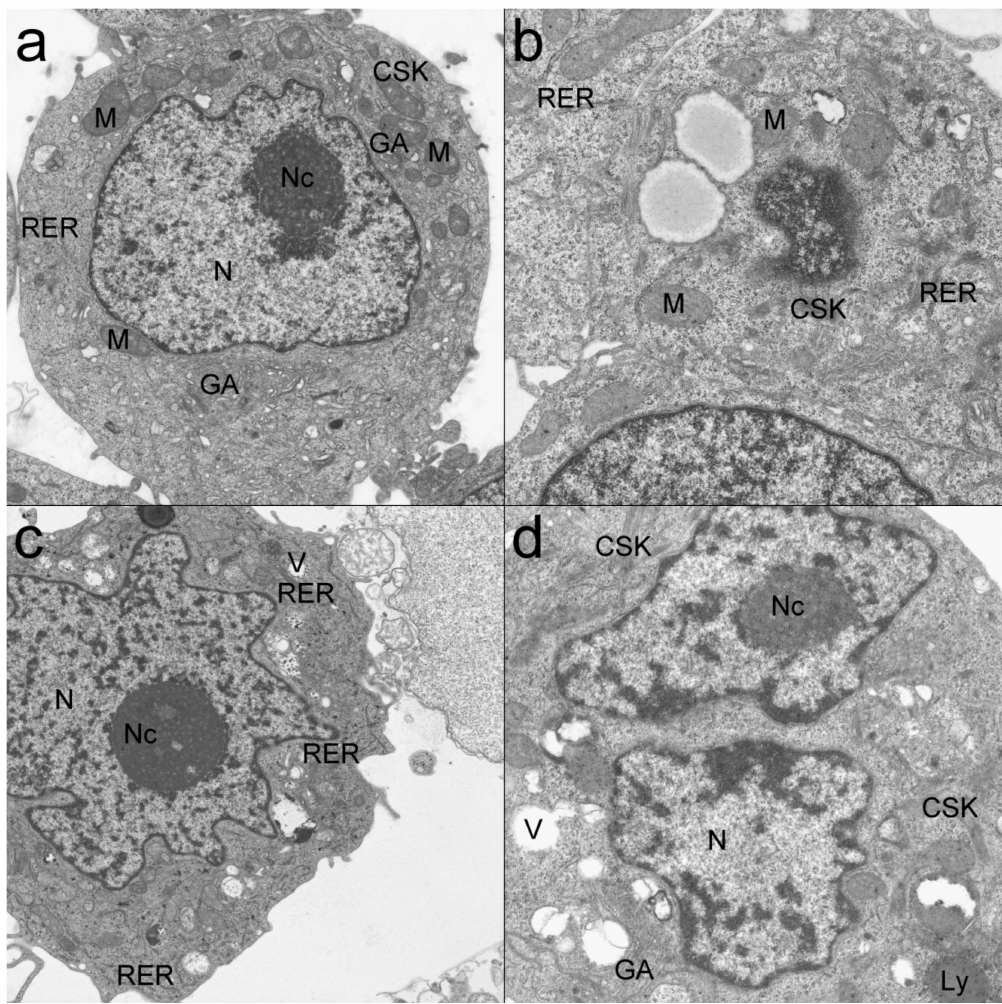
Figure 11. Ultrastructure of breast adenocarcinoma doxorubicin-resistant cells (MCF-7 / DOX). ( A )—Control, nontreated cells; ( B )—Cells after exposure to doxorubicin (DOX = 1.7 µ M ) ; ( C )—Cells after EP (EP = 1000V / cm,100 µ s,8pulses,1Hz);( D )—CellsafterECTwithdoxorubicin. Abbreviations: CSK—cytoskeleton; GA—Golgi apparatus; Ly—Lysosome; M—mitochondria; N—nucleus; Nc—nucleolus; RER—rough endoplasmic reticulum; V—vacuole; (original magnification 8A, 8B, 8C × 7000; 8D ×